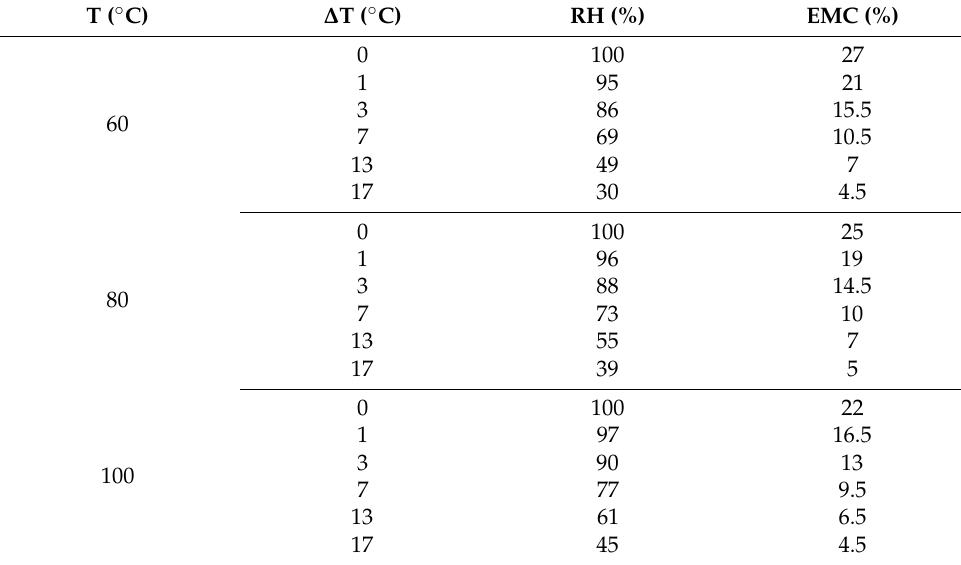
Table 1. Drying conditions of test strips used for free drying shrinkage performance tests. T ( ◦